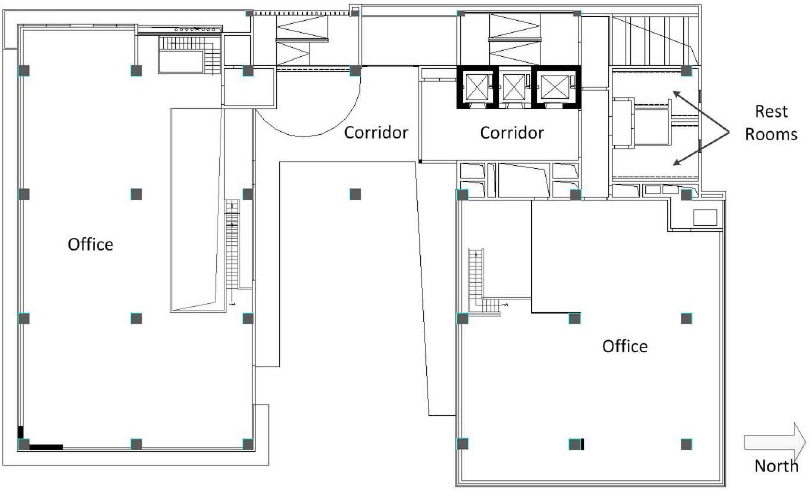
Figure 4. Shenzhen Institute of Building Research (IBR) building floor plan (7–12